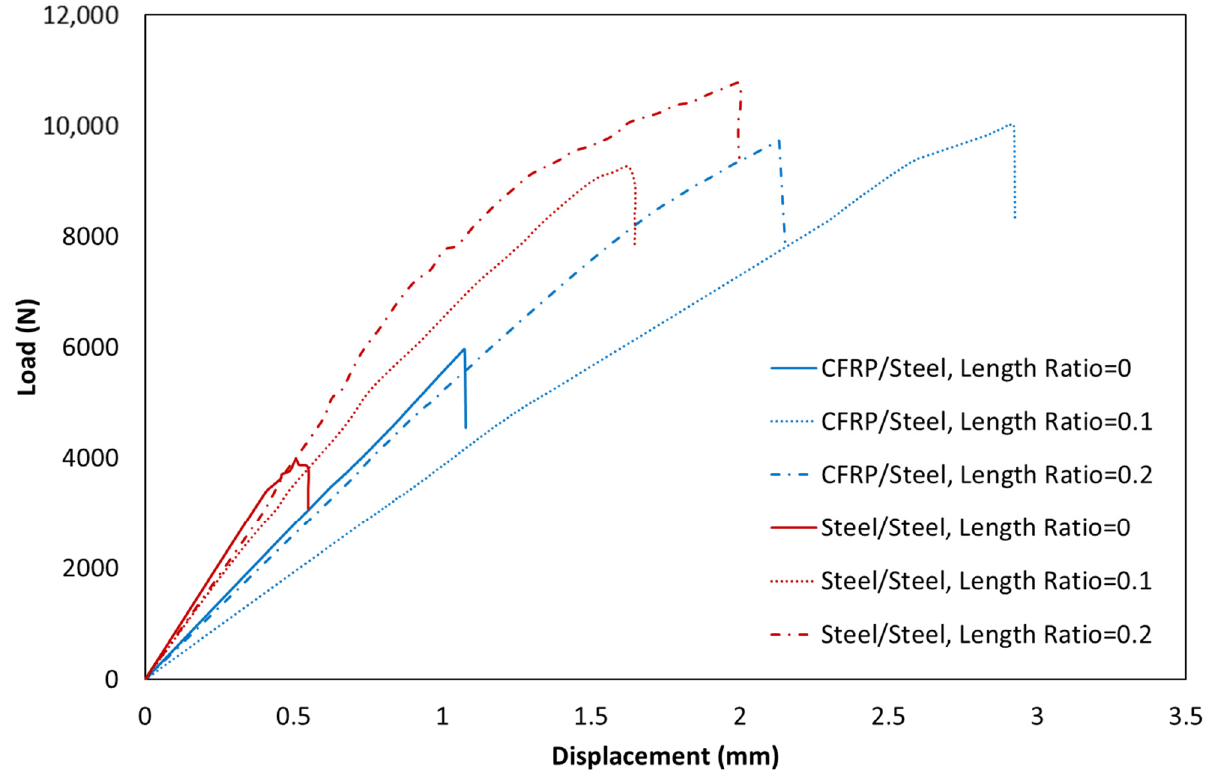
Figure 5. Load–displacement curve of similar (steel/steel) and dissimilar (CFRP/steel) joints under static loading conditions.